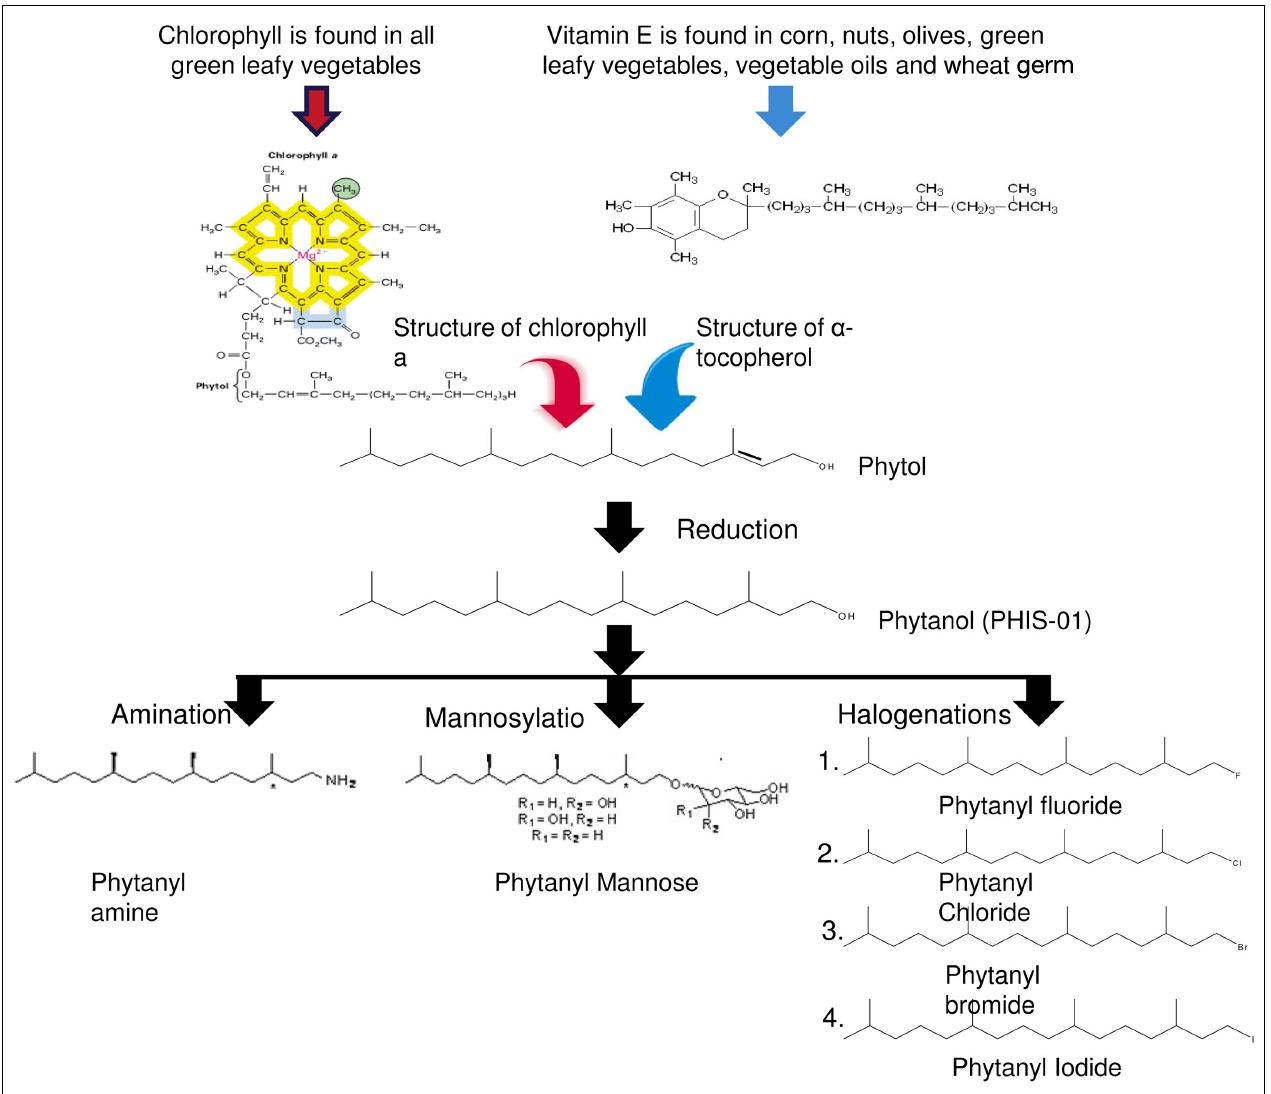
FIGURE 2 | Structures and chemical modifications of phytol-derived